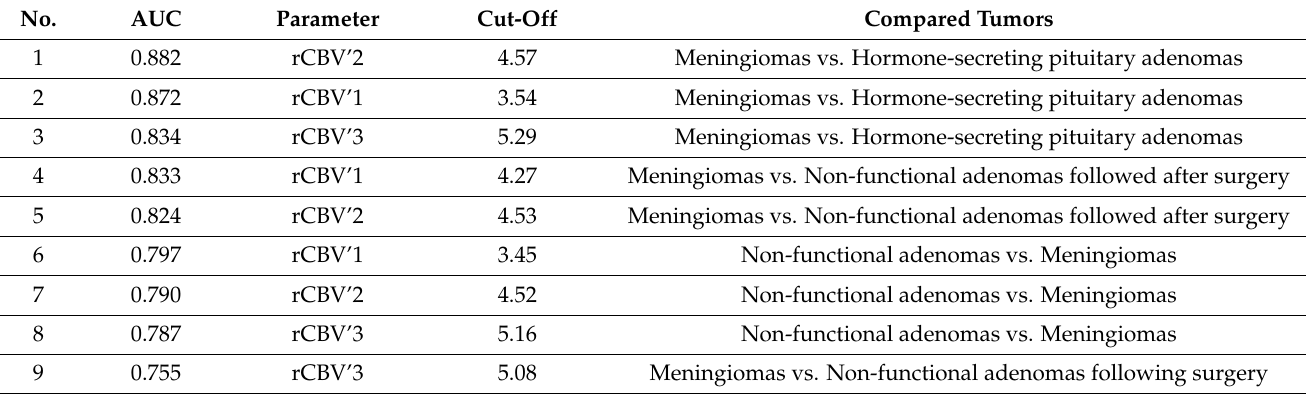
Table 2. Analysis of receiver operating characteristic (ROC) curves for rCBV parameter.